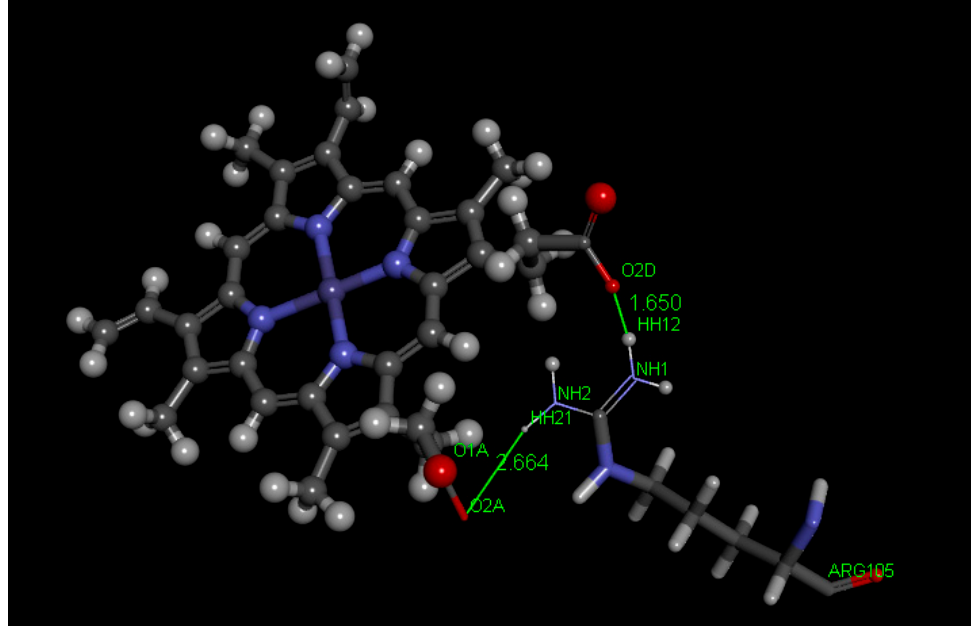
Figure 6. Heme stabilization in pose 6 is helped by hydrogen bonds to both terminal NH 2 groups of Arg105.